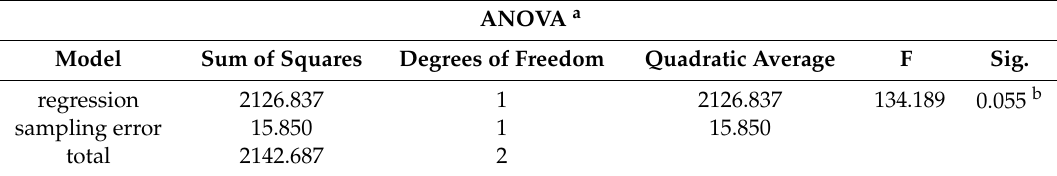
Table 13. Analysis of variance: Wheel-tracking test and first modulus of the plate bearing